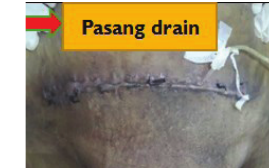
Figure 3. Follow up day 26 after drainage